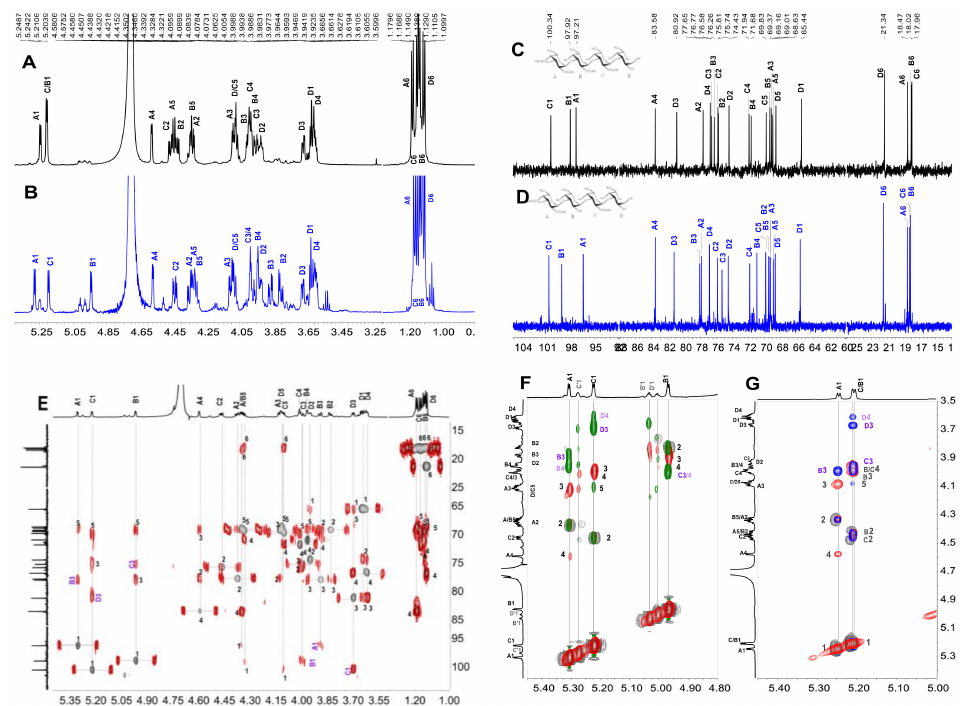
Figure 4. The 1 H ( A , B ) and 13 C ( C , D ) spectra of FVI and FV; the overlapped 1 H- 13 C HSQC (gray) and ROESY (green in ( F ) and blue in ( G )); and the overlapped spectra of FV ( F ) and FVI ( G ).